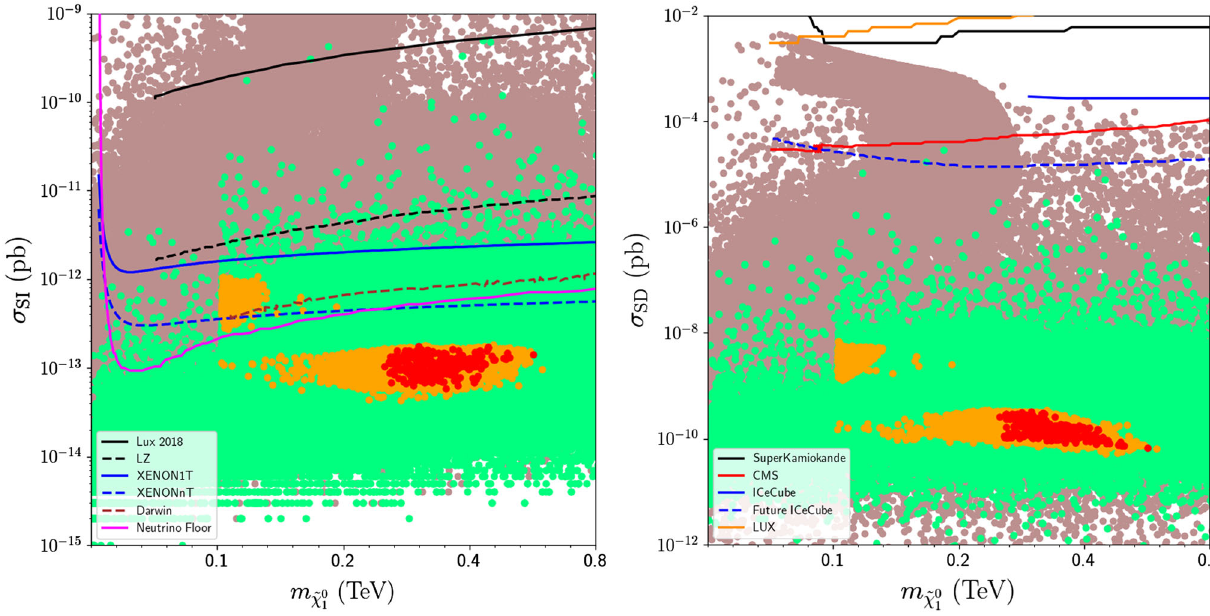
Fig. 10 Spin-independent (left) and spin-dependent (right) scattering cross-section in correlation with the LSP neutralino mass. The color coding is the same as in Fig. 6. The curves represent the current and projected exclusion curves from several direct detection DM experi-